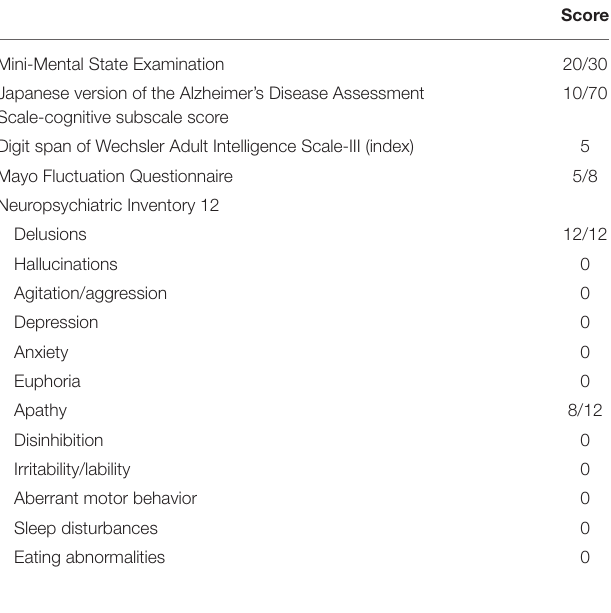
TABLE 1 | The results of neuropsychological tests and the Neuropsychiatric Inventory (NPI).